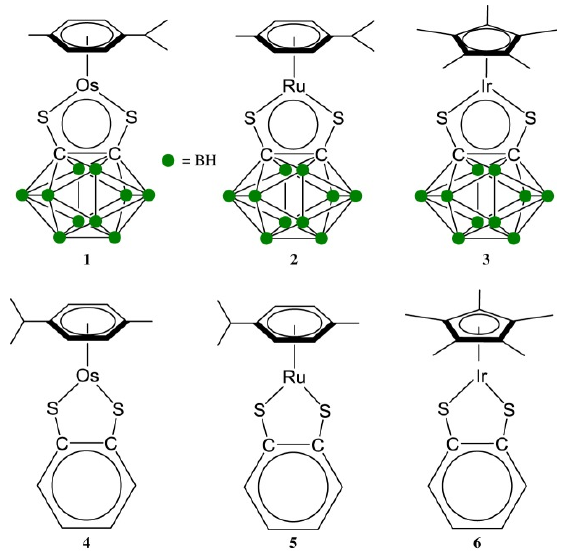
Figure 5. Molecular structures of the electron-deficient half-sandwich metal complexes studied in this work [4].